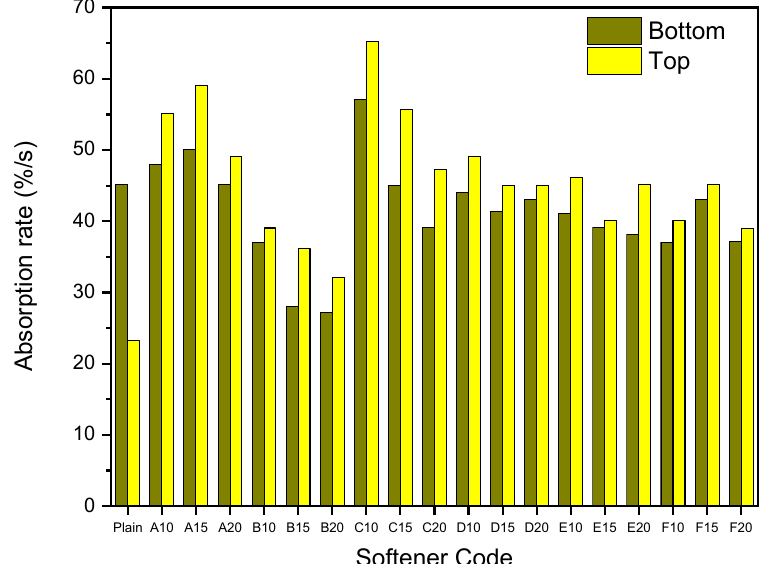
Figure 3. The absorption rate of terry knitted fabric with the application of different